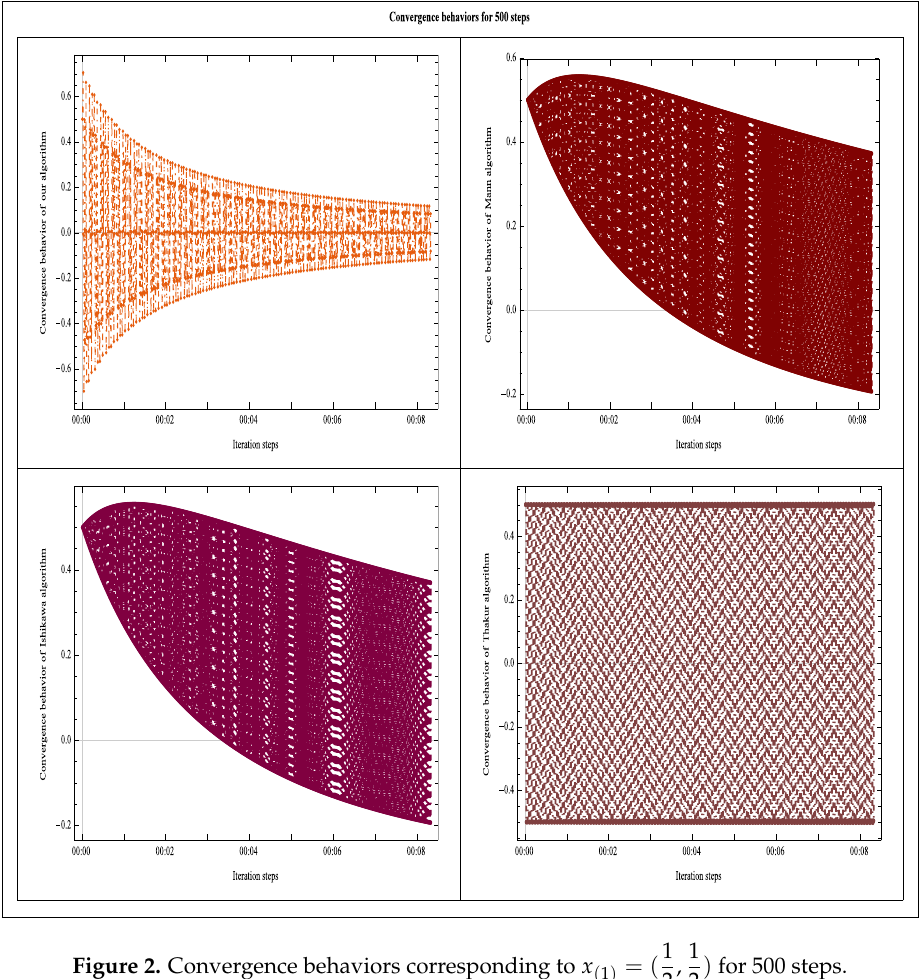
Figure 2. Convergence behaviors corresponding to x ( 1 ) = (